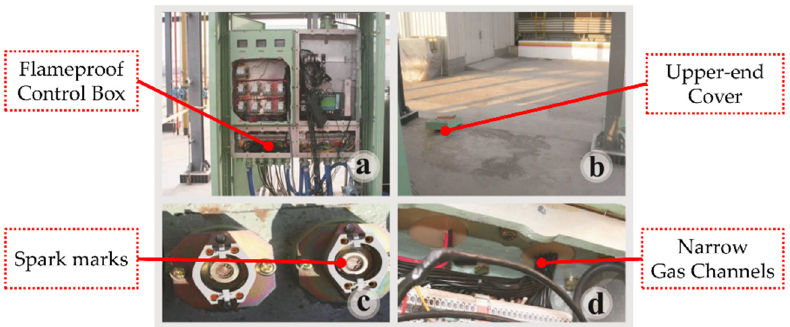
Figure 1. Burst accident of flameproof electrical equipment.